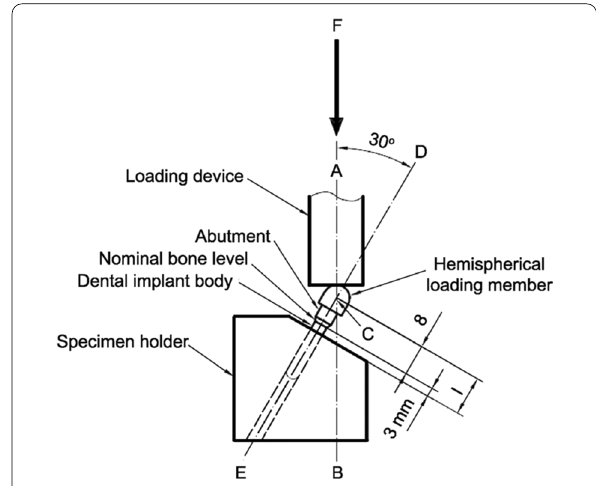
Fig. 1 Fatigue test setup according to ISO 14801 [27]